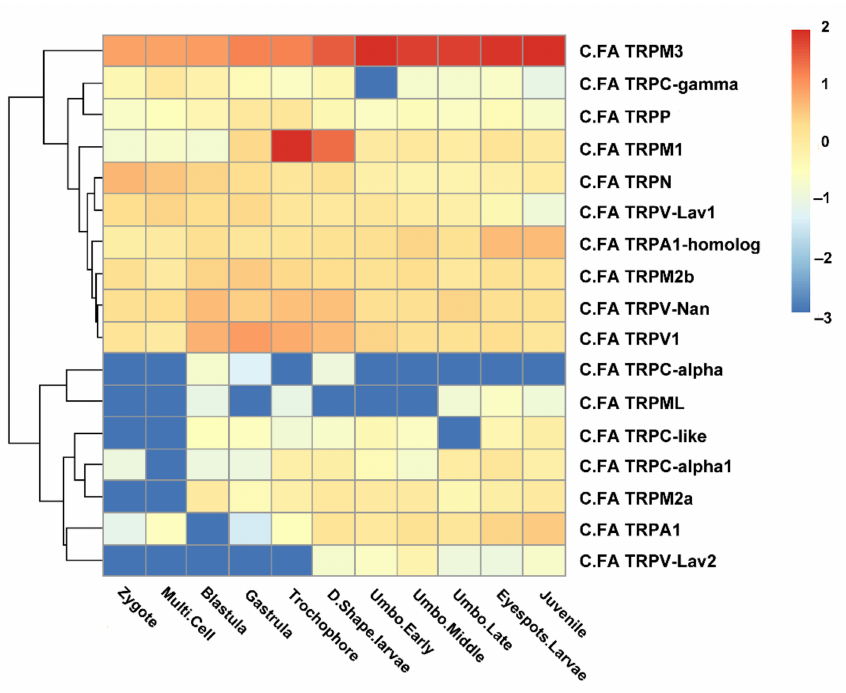
Figure 4. A heat map summarizing the expression of C.FA TRP genes during different development stages based on the Log 10